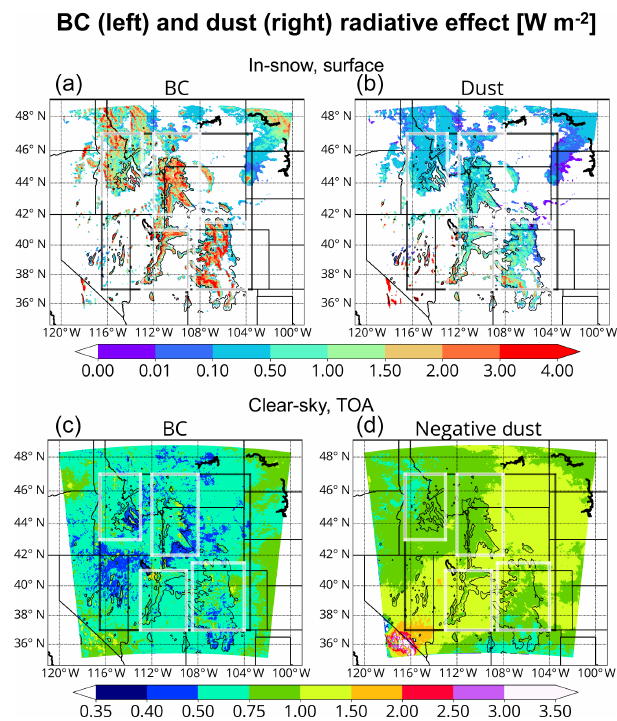
Figure 7. Surface in-snow (a, b) and top-of-the-atmosphere (TOA) clear-sky (c, d) radiative effect for (a, c) BC and (d, b) dust averaged from March through June (Wm − 2 ). The in-snow radiative effect panels (a, b) make use of the 18:00UTC output files only, while the TOA radiative effect panels (c, d) make use of the 00:00, 06:00, 12:00, and 18:00UTC output